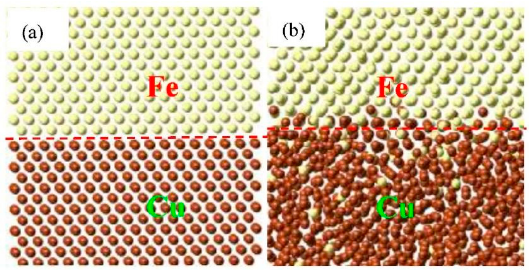
Figure 6. Atomic snapshots concerning Kirkendall effect of the Fe/Cu bimetallic interface. ( a ) Initial atomic structures; ( b ) the final atomic structures after the diffusion at 1523 K.